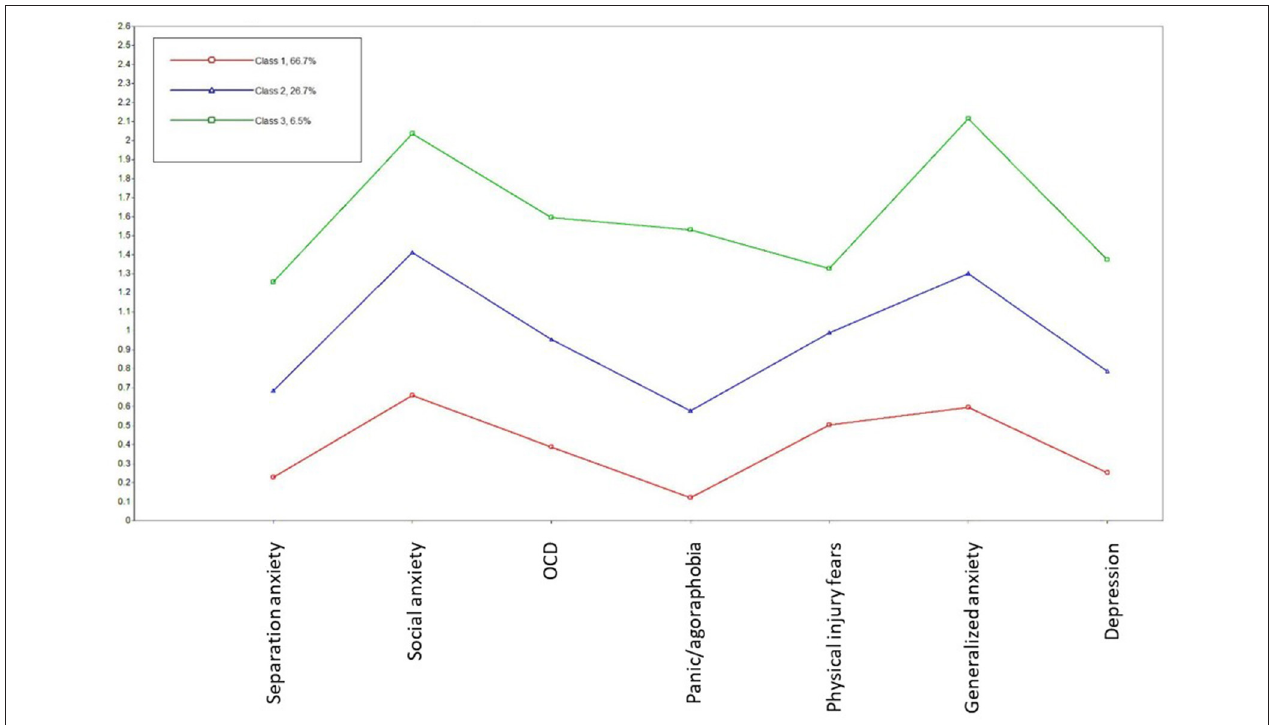
FIGURE 2 | Three latent profiles of internalizing symptoms across a foster care, clinical, and general population youth samples. Low symptom profile, n = 1,366; medium symptom profile, n = 507; high symptom profile, n = 120.